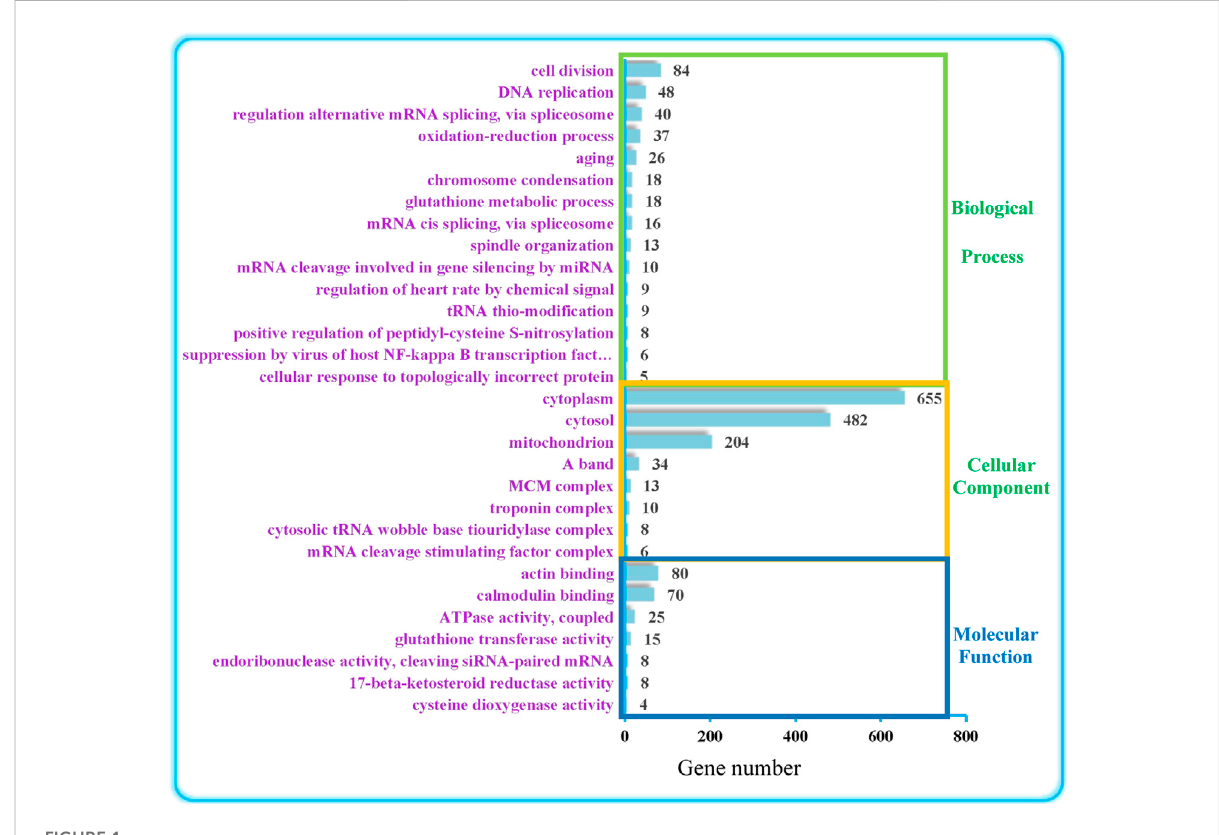
FIGURE 1 Top 30 GO terms. The numbers on the right represent the number of DEGs in each